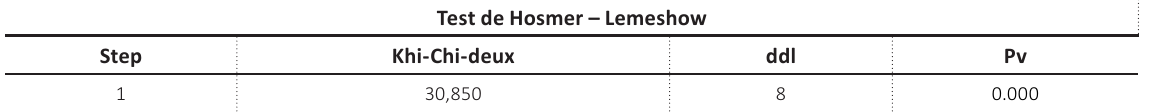
Test de Hosmer – Lemeshow